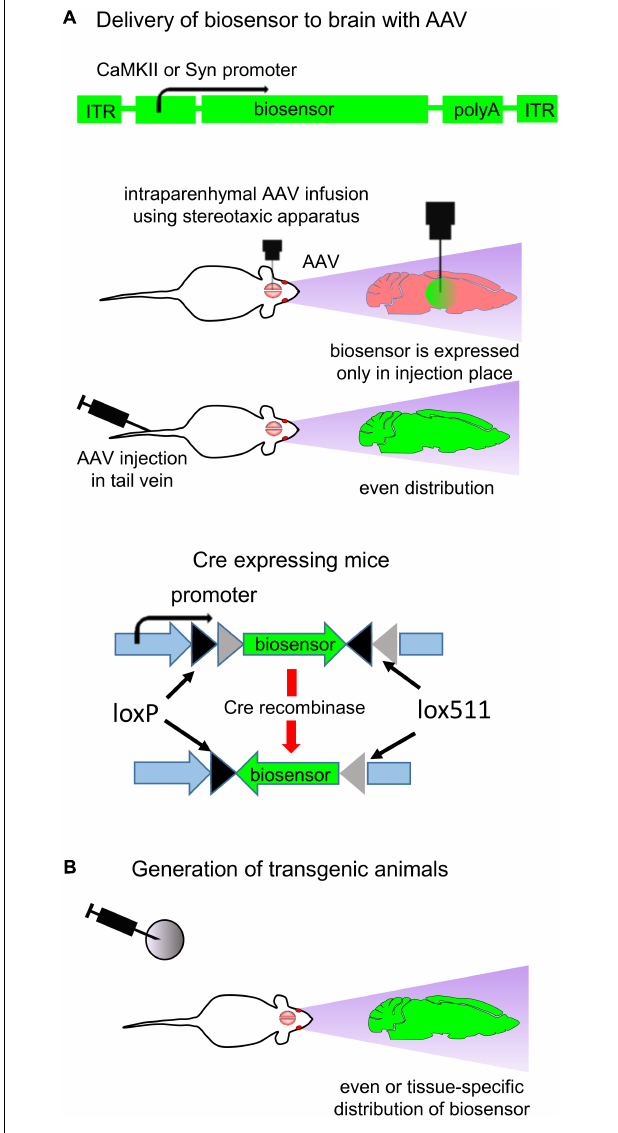
FIGURE 4 | Expression of biosensors in vivo . (A) Delivery of biosensors to the animal brain using AAV particles. A typical structure of the AAV vector is shown (top). AAV transduction in adult animals can be performed by either stereotactic injection in the brain or tail injection (middle). Brain injection requires the stereotactic surgery, and the biosensor expression is restricted to the injection point. Via tail injection AAV are delivered to the whole body. The neuronal-specific promoters, such as for CaMKII kinase and Synapsin, provide biosensor expression in CNS (Stoica et al., 2013). Use of cell-specific Cre recombinase expression and AAV in which gene of biosensor is inverted and flanked with loxP and lox511 sequences allows to achieve cell-specific biosensor expression (bottom) (B) Generation of transgenic animals allows to achieve either even or cell-specific expression of biosensor in the animal brain (Xie et al.,